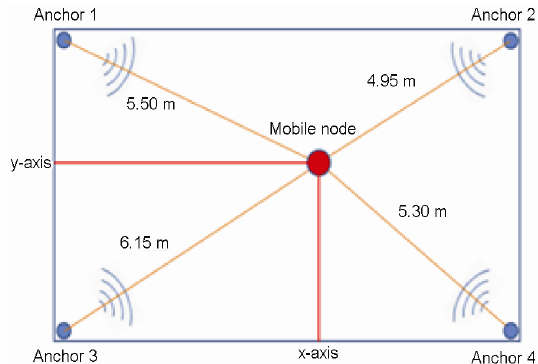
Fig. 2. Location identification measurement using TOA algo- rithm inside tunnel (Kim